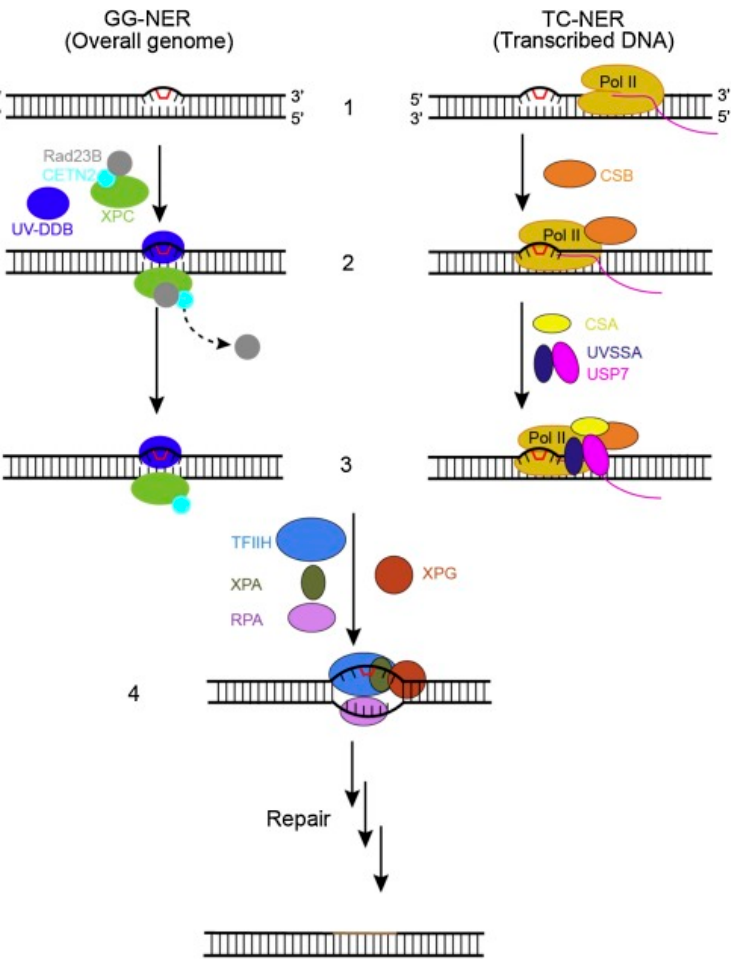
Figure 4. Schematic representation of the two sub ‐ pathways of nucleotide excision repair (NER). In the GG ‐ NER sub ‐ pathway, the damage sensor XPC and the UV excision repair protein homolog B (RAD23B) and centrin 2 (CETN2) complex bind the non ‐ damaged strand with the help of the UV– DDB complex, as shown in the second step. The binding of this complex to the damaged site disso ‐ ciates the RAD23B from the complex, as displayed in the third step. In the TC ‐ NER, the initiation of damage recognition is performed by the stalling of RNA polymerase II (Pol II). This stalled Pol II activates CSB, resulting in the formation of the Pol II–CSB complex, which serves as a platform for further recruitment of other repairing factors such as CSA and UVSSA ‐ USP7. After recognizing the damage in the first three steps (step 1–3), the TFIIH complex is then recruited to the lesion in both the sub ‐ pathways, along with XPA, RPA, and XPG, as shown in the fourth step. Following the ver ‐ ification of the DNA lesion, dual incisions occur resulting in the removal of the damage ‐ containing DNA short fragment, which is then followed by the synthesis of a new DNA fragment, and the completion of the NER reaction by sealing the final nick by DNA ligase [74]. 3. DDR Inhibitors for a Targeted Treatment of Lung Cancer When genotoxic stress occurs, there are three phosphatidyl inositol 3 ‐ kinase ‐ related protein kinases involved, although each one is activated by different types of injury [23]. ATM has been reported to show a response toward DNA ‐ damaging agents, such as IR, which causes DSBs [80]. Both ATM and ATR kinase have been reported to detect altera ‐ tions occurring in cell replication upon exposure to ultraviolet light (UV) [81]. Similar to the ATM, another signaling pathway, DNA ‐ PK, has also been shown to be recruited in response to DSBs under certain cellular conditions, such as environmental carcinogens, IR exposure, and chemotherapeutic agents, as well as in cells that have shortened telomeres